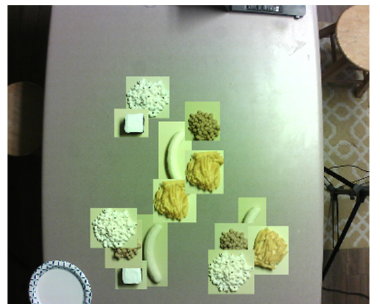
Figure 5. Random positioning of the test items on the table. The area covered by the FOODCAM was predetermined by capturing a test pair.